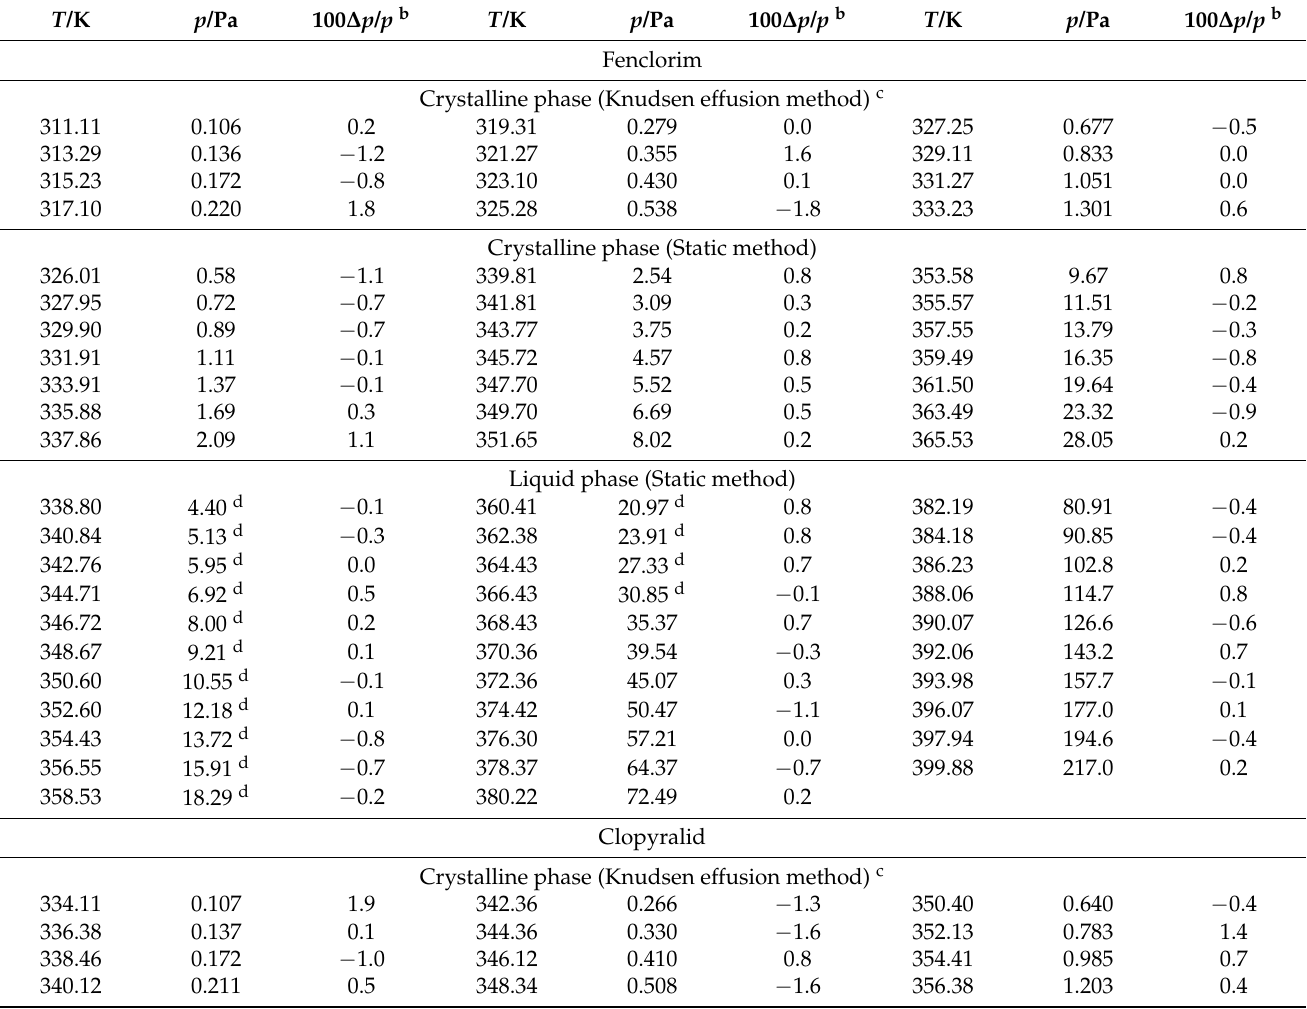
Table 2. Vapor pressure results a